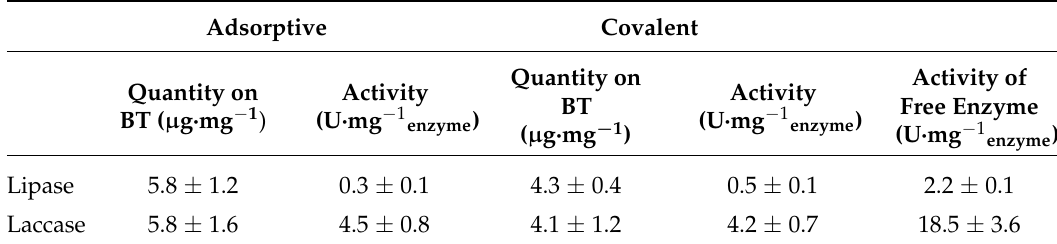
Table 2. Protein quantity and laccase- or lipase-specific activity, respectively, after adsorptive or covalent immobilization on BT. Covalent lipase immobilization was performed on acid pre-treated BT using EDC, whereas laccase was tethered on PEMA-BT. Further immobilization conditions were described in Table 4. n =